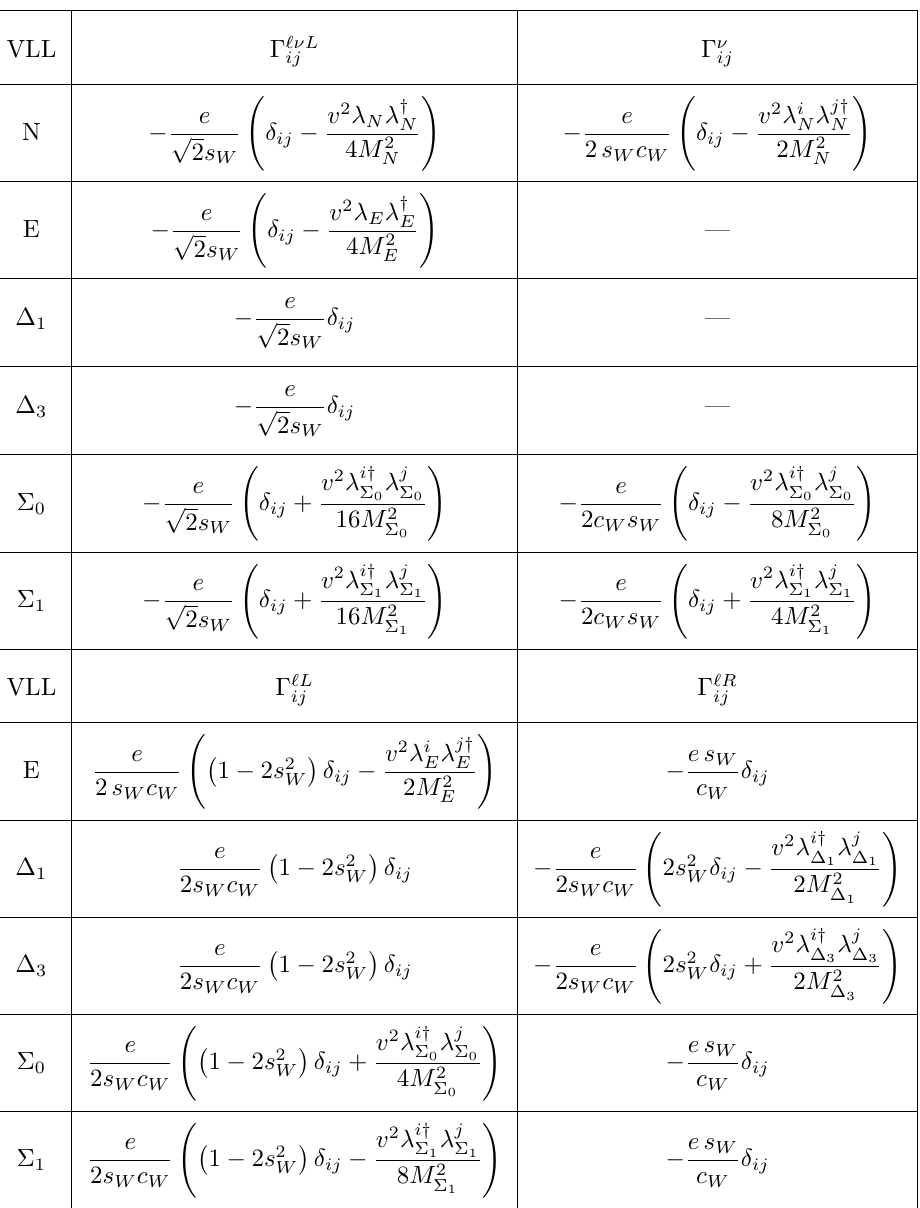
Table 6 . Couplings of W and Z to SM leptons including the corrections induced by